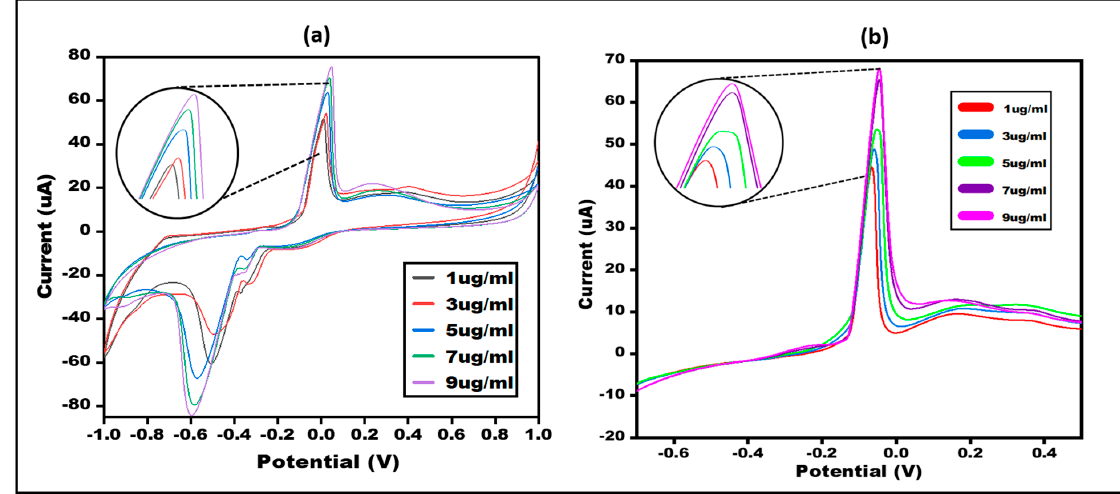
Figure 5. ( a ) CV of Bilirubin/Enzyme/Ag-NPs/PBs modified electrode using different concentrations of Bilirubin (1, 3, 5, 7, 9 µg/mL) in 10 mM PBS at 50 mVs − 1 in the potential range from -1 V to +1 V. ( b ) LSV of Bilirubin/enzyme/Ag-NPs/PBs modified electrode using different concentrations of Bilirubin (1, 3, 5, 7, 9 µ g/mL) in 10 mM PBS at 50 mVs − 1 in the potential range from − 1 V to +1 V.